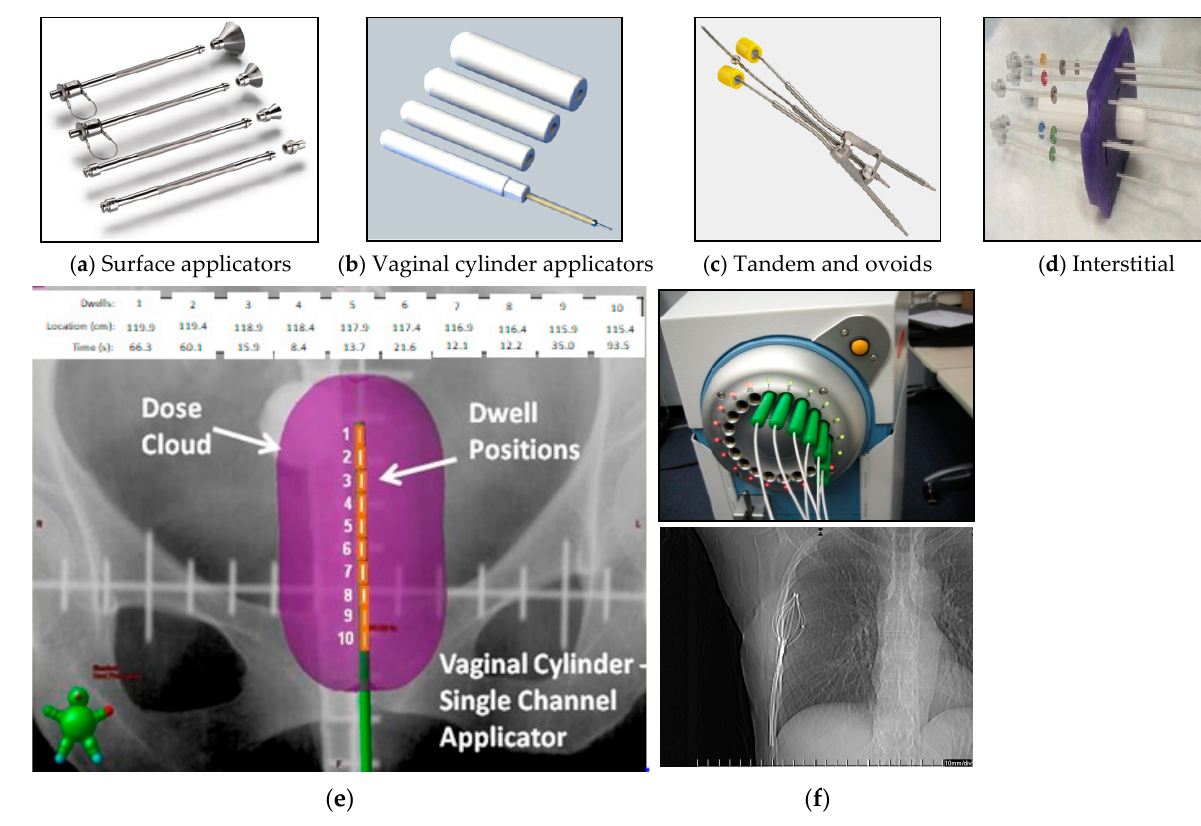
Figure 3. Surface applicators for skin cancer treatments ( a ), cylindrical applicators for vaginal and rectal cancer treatments ( b ), tandem and ovoids (Fletcher Suit) for cervical and uterine cancer treatments ( c ), interstitial needle array for interstitial gynecological or prostate treatments ( d ), number of dwells (1–10), dwell positions (locations in cm), dwell times (s), and dose distributions for a brachytherapy treatment using a cylindrical applicator [33]. ( e ). SAVI applicator catheters connected to a 192 Ir HDR source ( f-top ) and coronal radiograph of the SAVI applicator inside a patient ( f-bottom ).